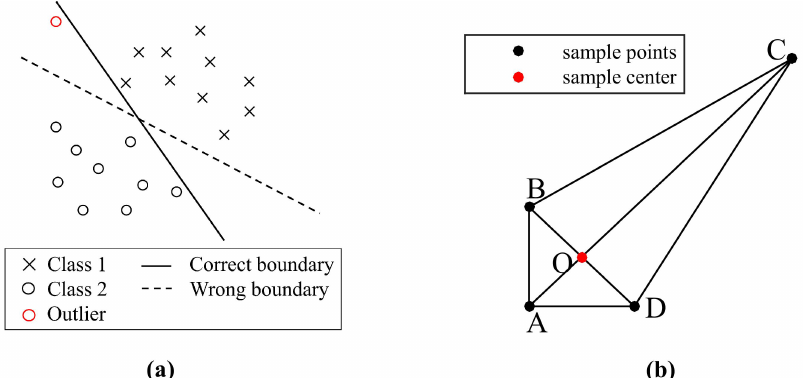
Figure 1. Outlier and sample center. ( a ) The influence of outlier, where Class 1 and Class 2 represent the samples of two different type of targets. ( b ) Sample center of four points.